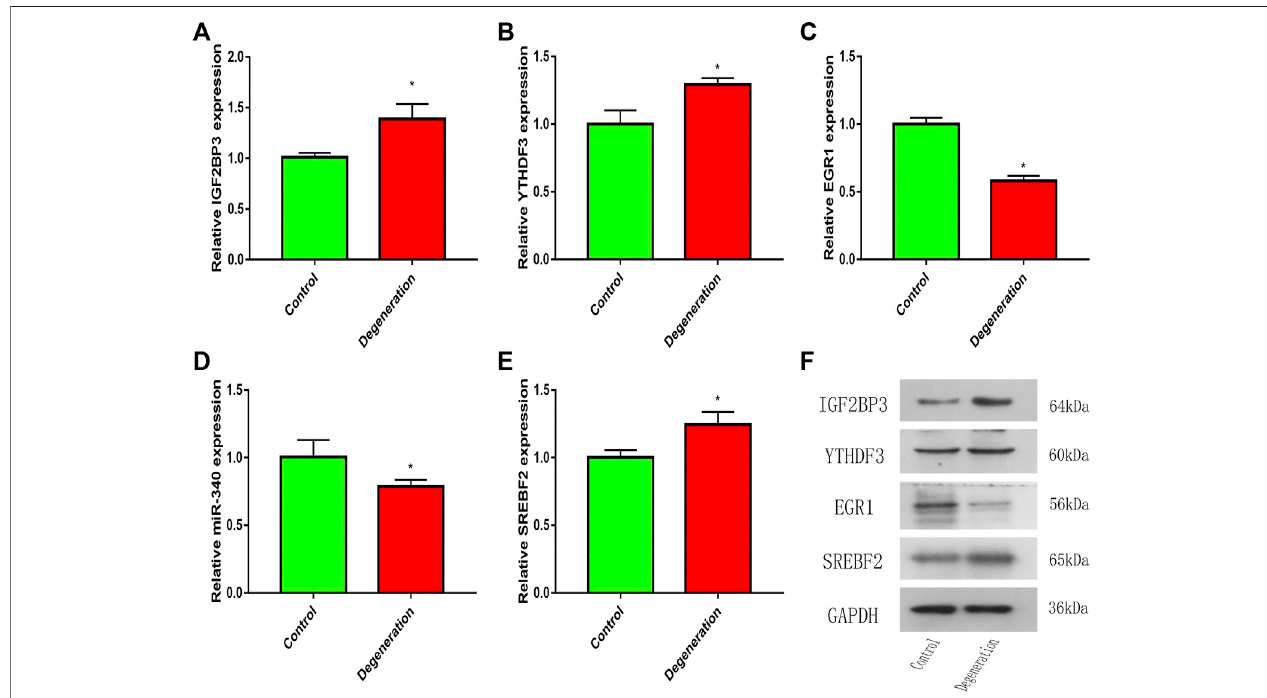
FIGURE 9 | The mRNA or miRNA expression in the control and degeneration group. (A,B) Expression level of m6A genes in the control and degeneration group. (C – E) Expression level of m6A-related transcription factor and miRNA in the control and degeneration group. (F) Expression level of m6A protein and m6A-related transcription factor in the control and degeneration group. * p < 0.05 vs.